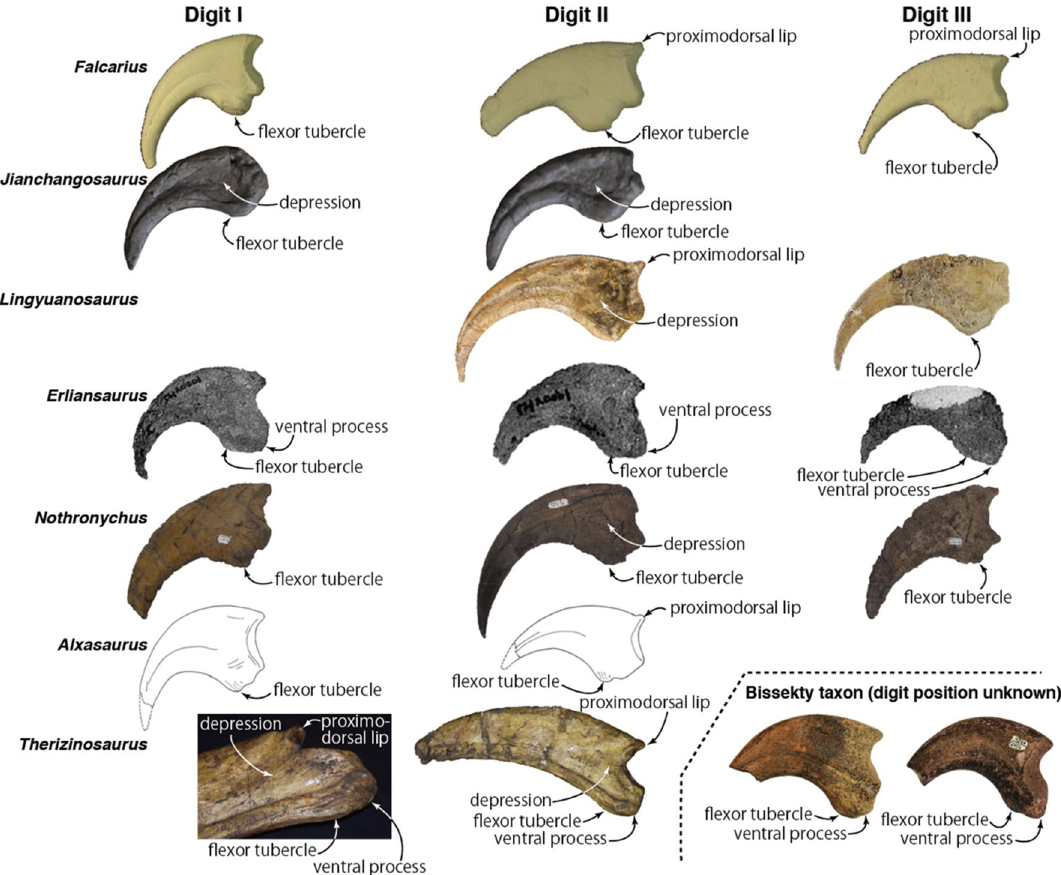
Figure 5. Comparisons of manual unguals in digits I-III of therizinosaurs. An image at the lower left corner is a photo of the proximoventral end of Therizinosaurus ungual in oblique view. Not to scale. This figure was created by using Adobe Photoshop 21.2.0 and Adobe Illustrator 24.2.1 (https:// www. adobe. com/).